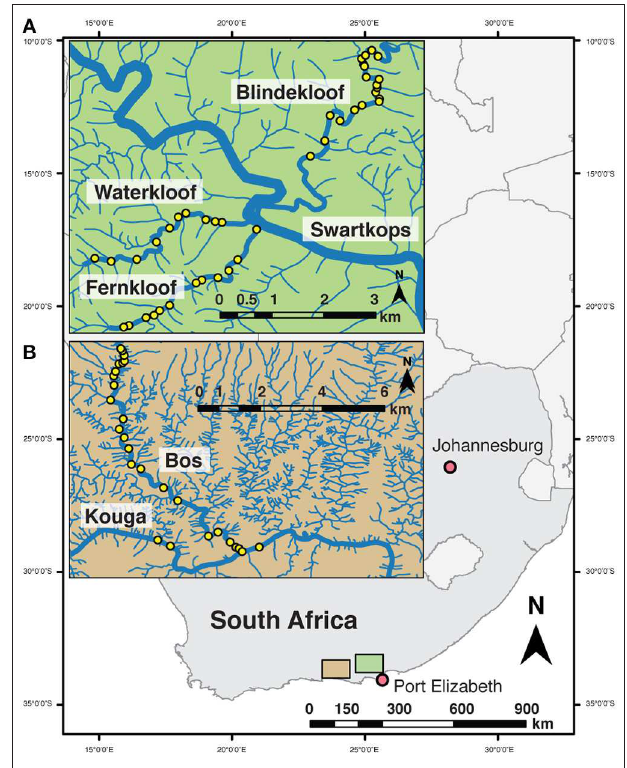
FIGURE 1 | Location of sampling sites (yellow points) across two watersheds in Eastern Cape, South Africa; (A) Swartkops watershed within the Groendal Nature Reserve; and (B) Kouga watershed, Bos River tributary within the Skilderkrantz Nature Reserve.